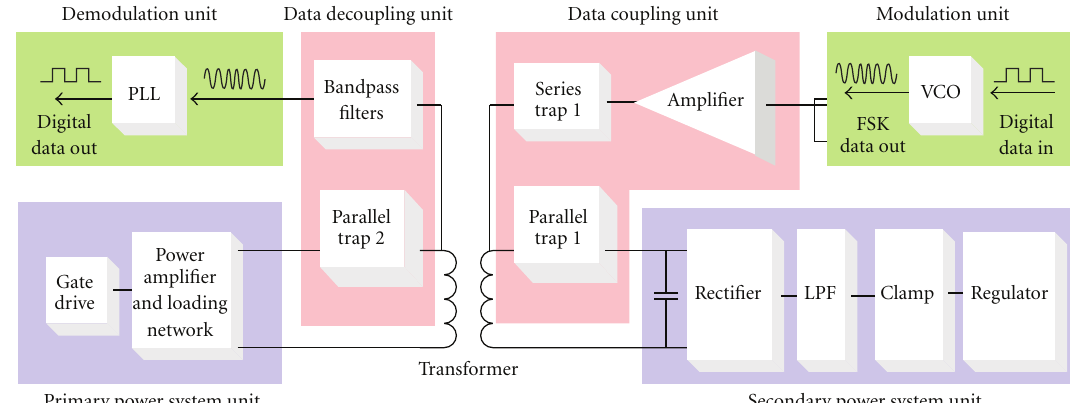
Figure 1: Detailed system block diagram of inductive